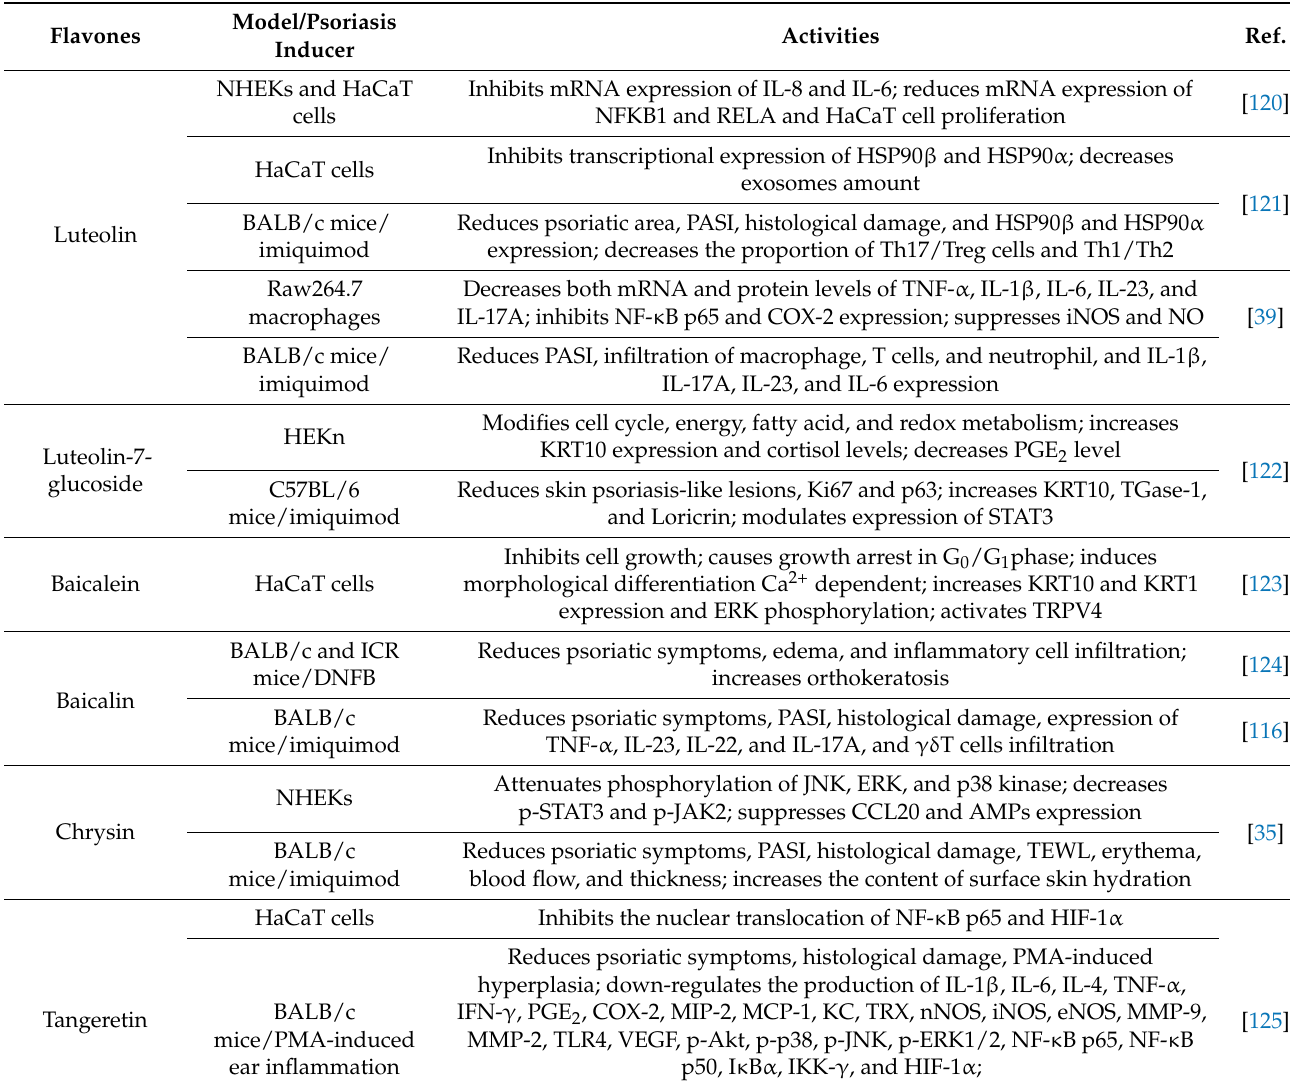
Table 6. Beneficial properties of flavones in different psoriasis